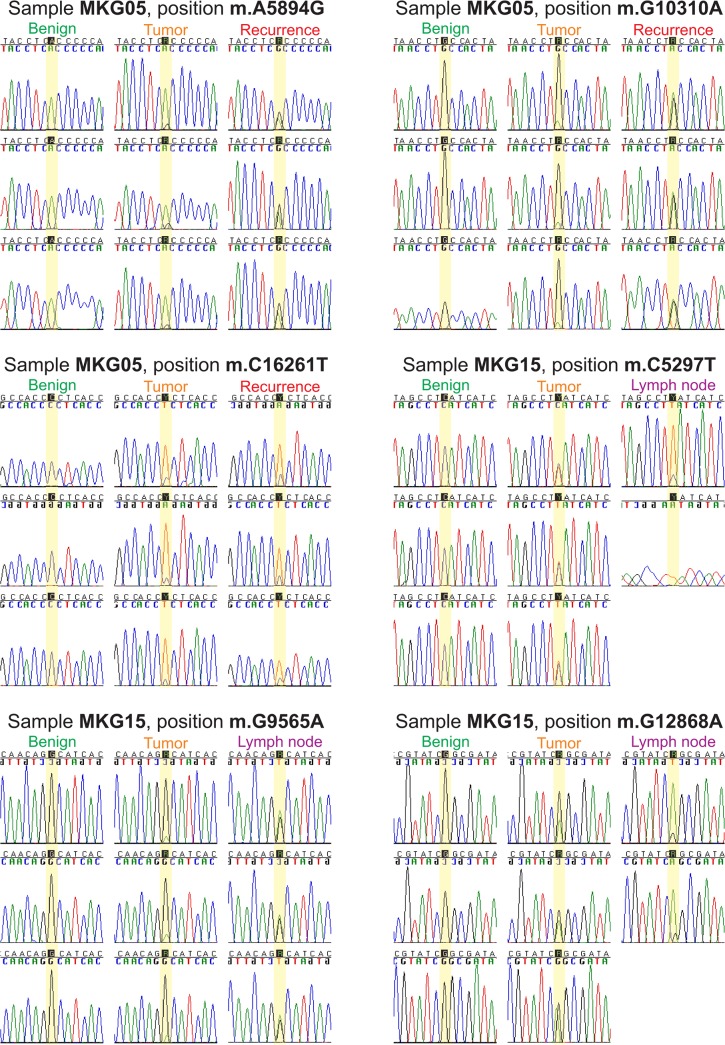
Heteroplasmic mutations as seen with Sanger sequencing in MKG05 and MKG15.The benign tissue was taken from the resection border of the tumor.